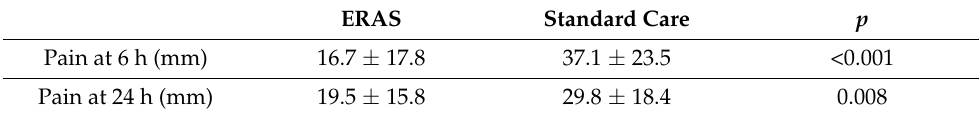
Table 4. Distribution of pain between groups. (Student ´ s t -test). ERAS Standard Care p Pain at 6 h